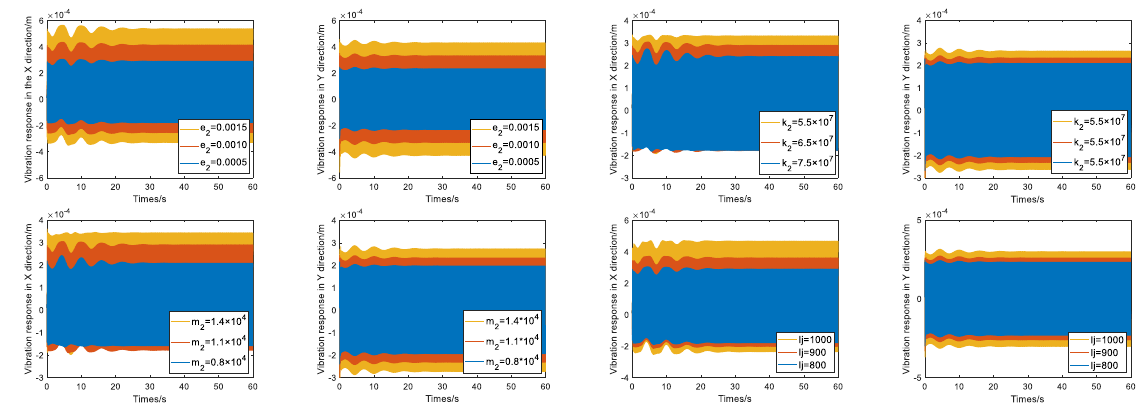
Figure 13. Shafting vibration response in the X direction and Y direction of the unit without vortex rope.